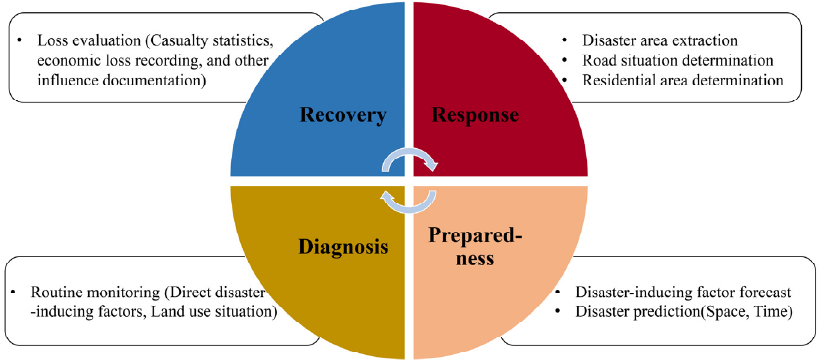
Figure 3. Observation needs from different emergency